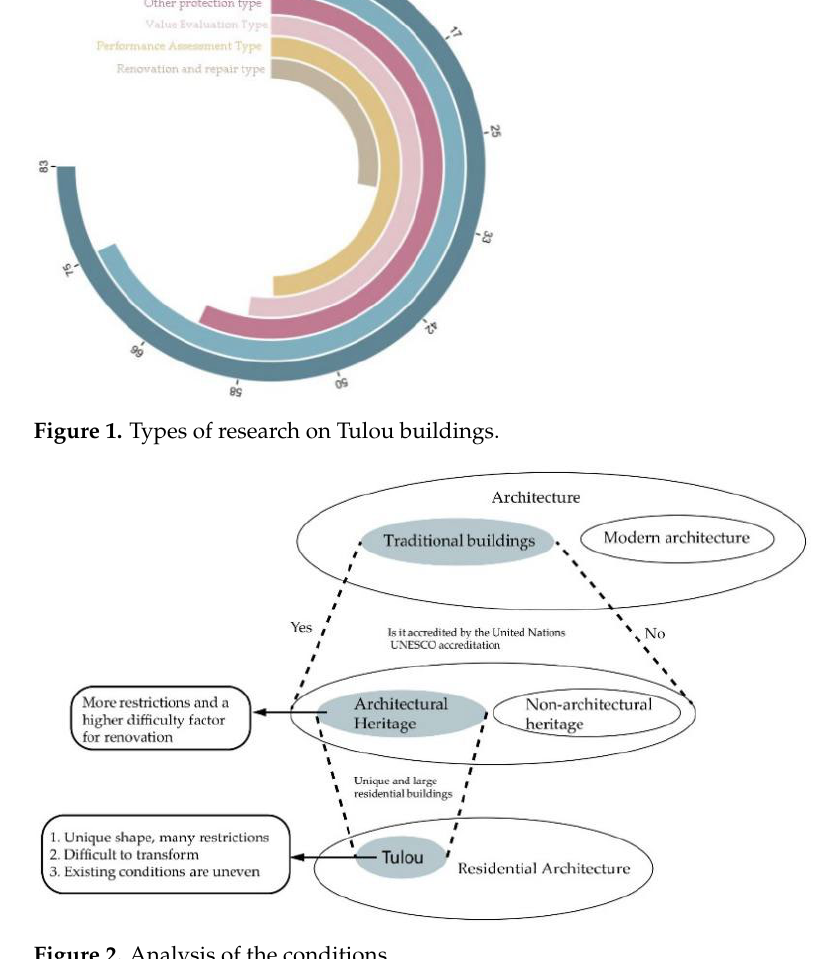
Figure 2. Analysis of the conditions.